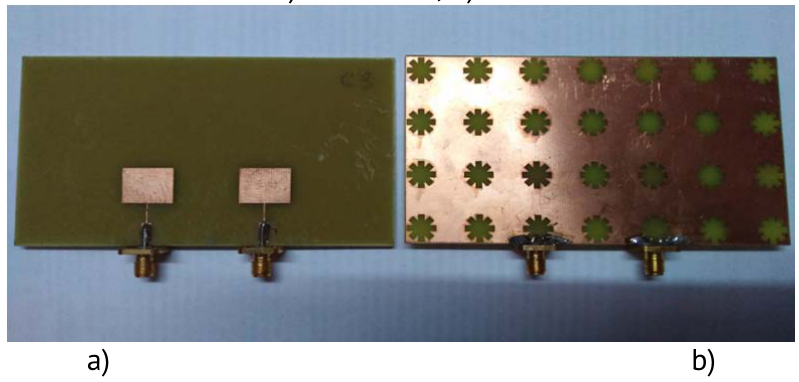
Figure 10. Photograph of setup of microstrip antenna array with star slot EBG structure for mutual coupling measurement: a) front view; b) back view.